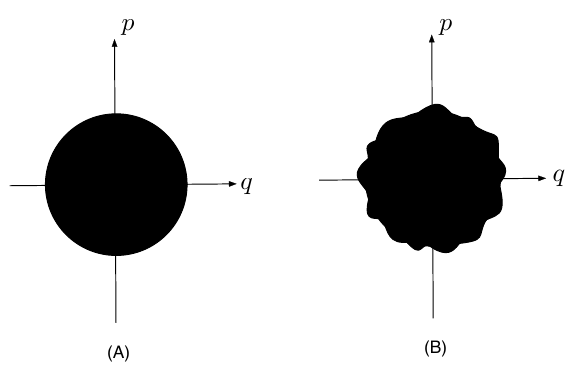
Figure 2 . (A) The density function for the Fermi sea corresponds to a black disc in the one-particle phase space, whose radius (cid:12)xes the AdS radius in the gravity dual. (B) Coherent states of the t k operators create shape deformations on the surface of the Fermi